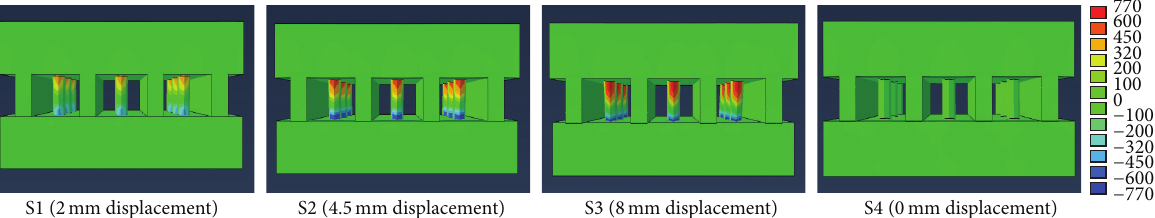
Figure 15: Axial stress component (S22) contours distributed over the SMA-0.10 model according to individual loading steps (Unit: Mpa).